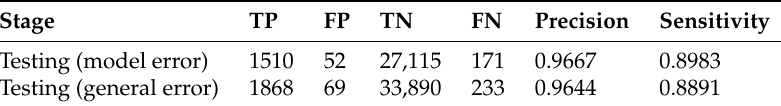
Table 2. Training Strategy I performance at learning rate 0.5.